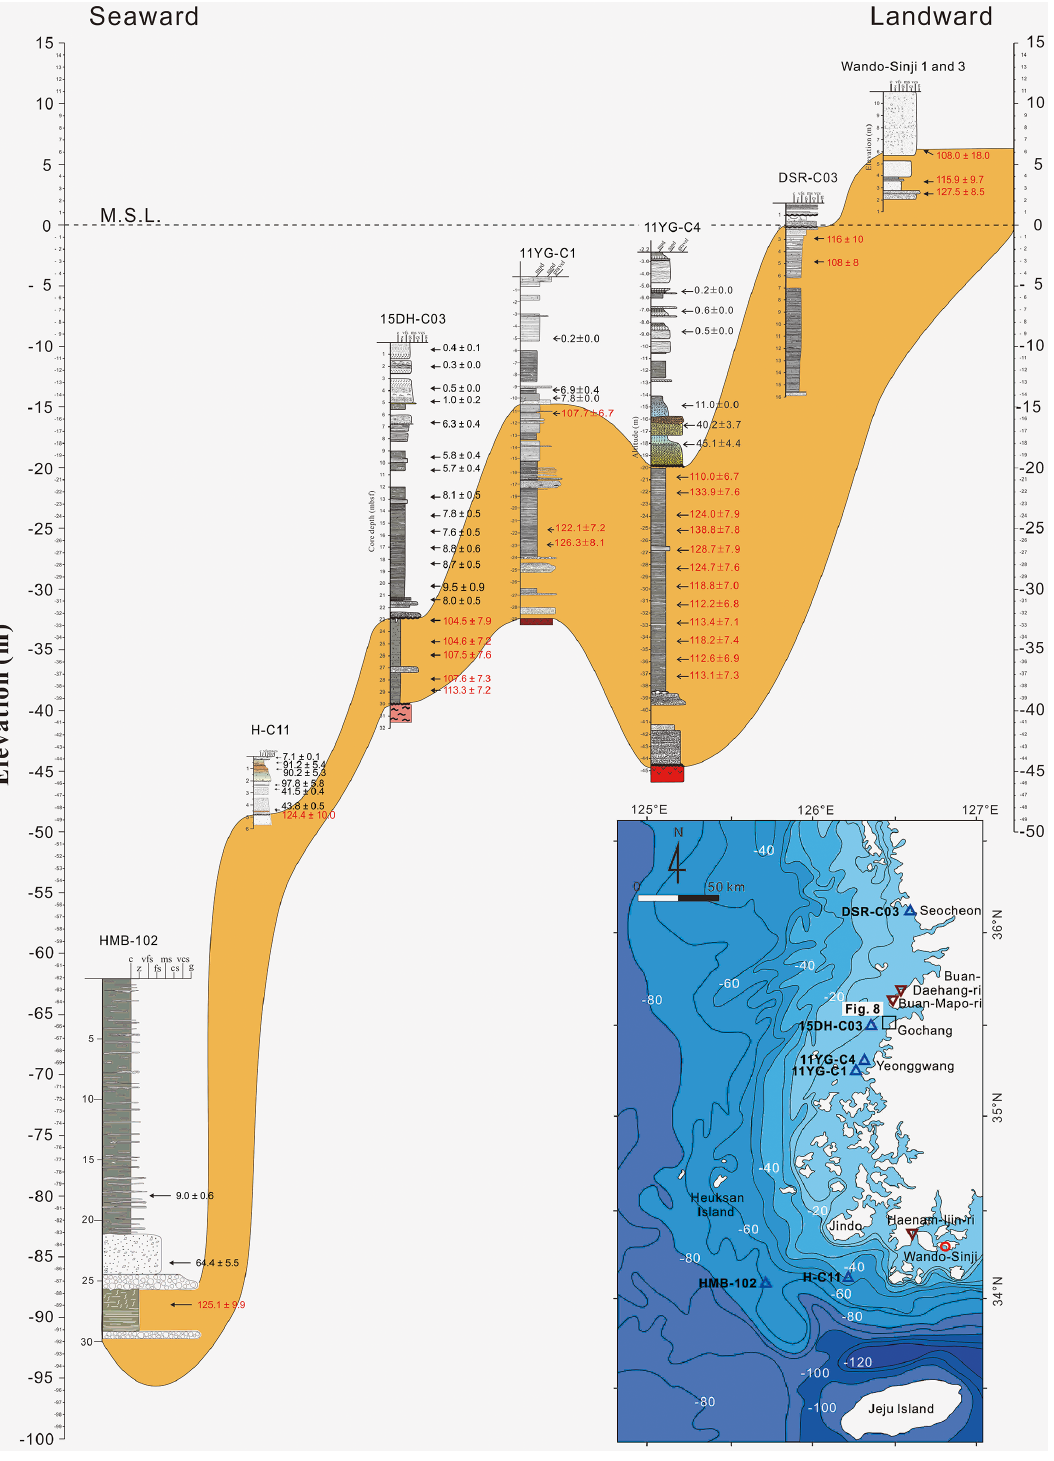
Figure 11. Onshore sections (Wando-Sinji 1 and 3) and tidal-to-nearshore cores (DSR-C03 to HMB-102) along the west coast of Korea plotted with respect to elevation of the remnant LIG deposits. Orange shading highlights the correlation of LIG deposits across the six coastal cores and Wando outcrop sections. Ages in red indicate LIG ages (WALIS LUM ID no. 470 to no. 491 in Table 3). For location, see Fig. 7.